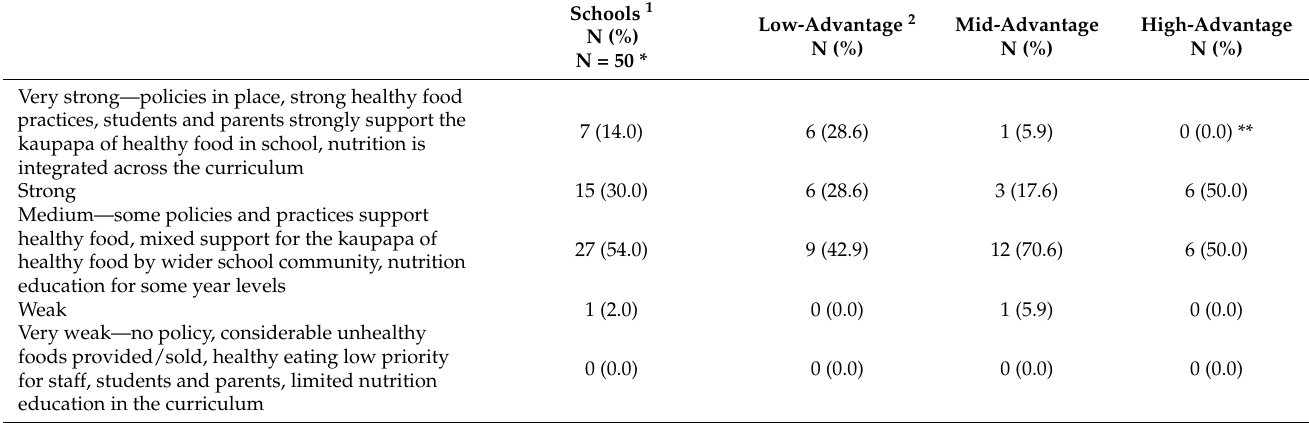
Table 4. Perceived culture around healthy eating in Hawke’s Bay